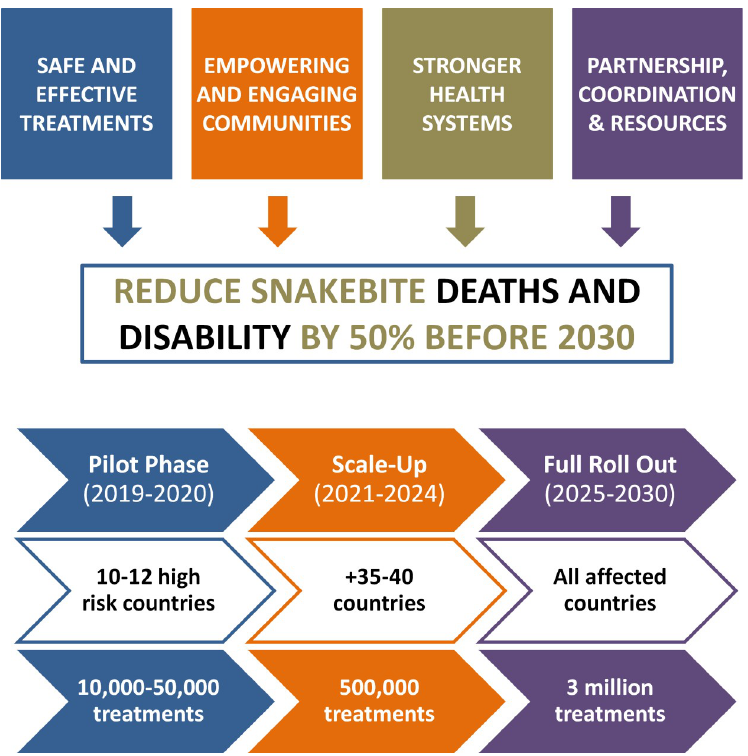
Fig 1. Summary of WHO snakebite envenoming road map objectives, impact goals, and timeline phases.